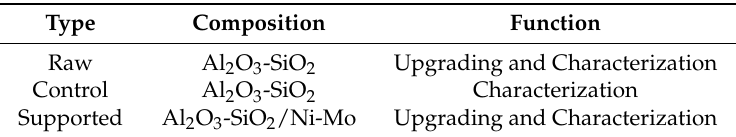
Table 7. Types of drill cuttings employed in